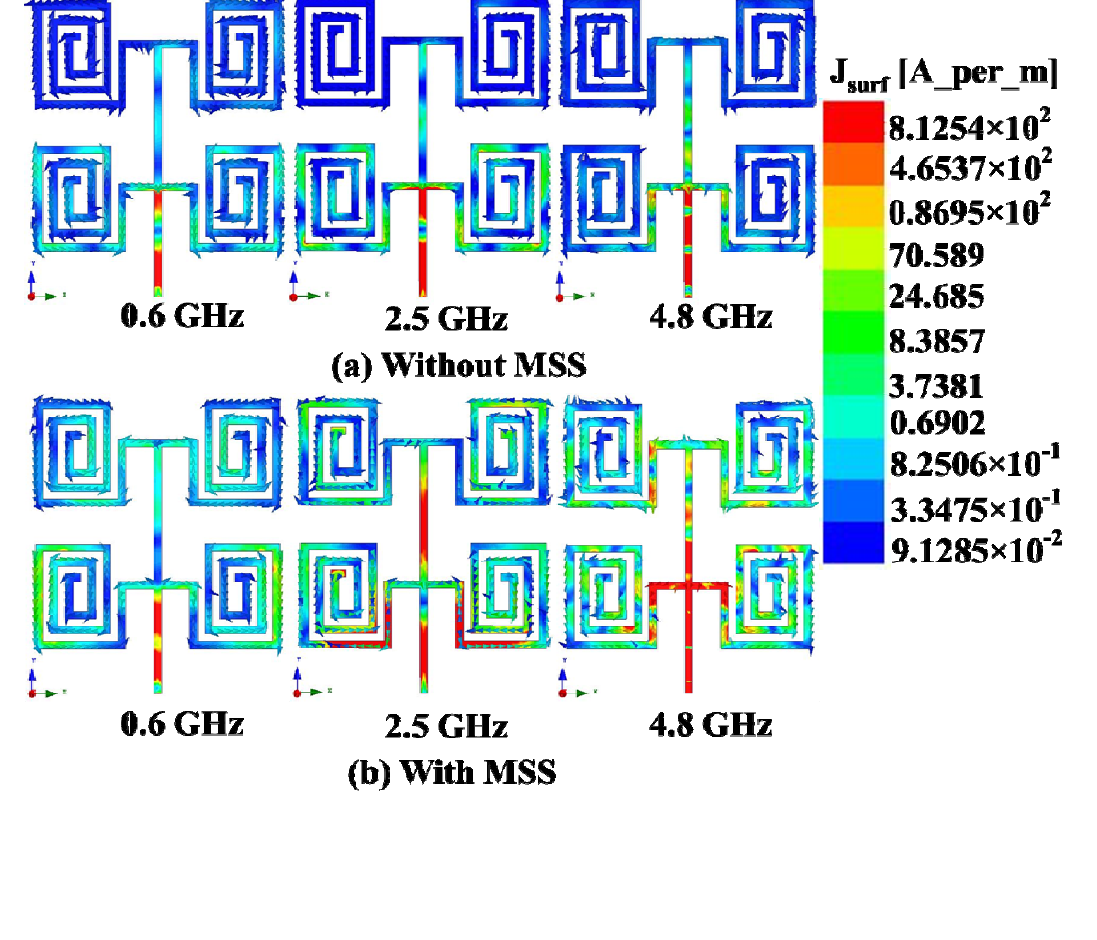
Figure 7. Surface current distribution ( a ) without MSS; and ( b ) with MSS on the radiating patch of the proposed